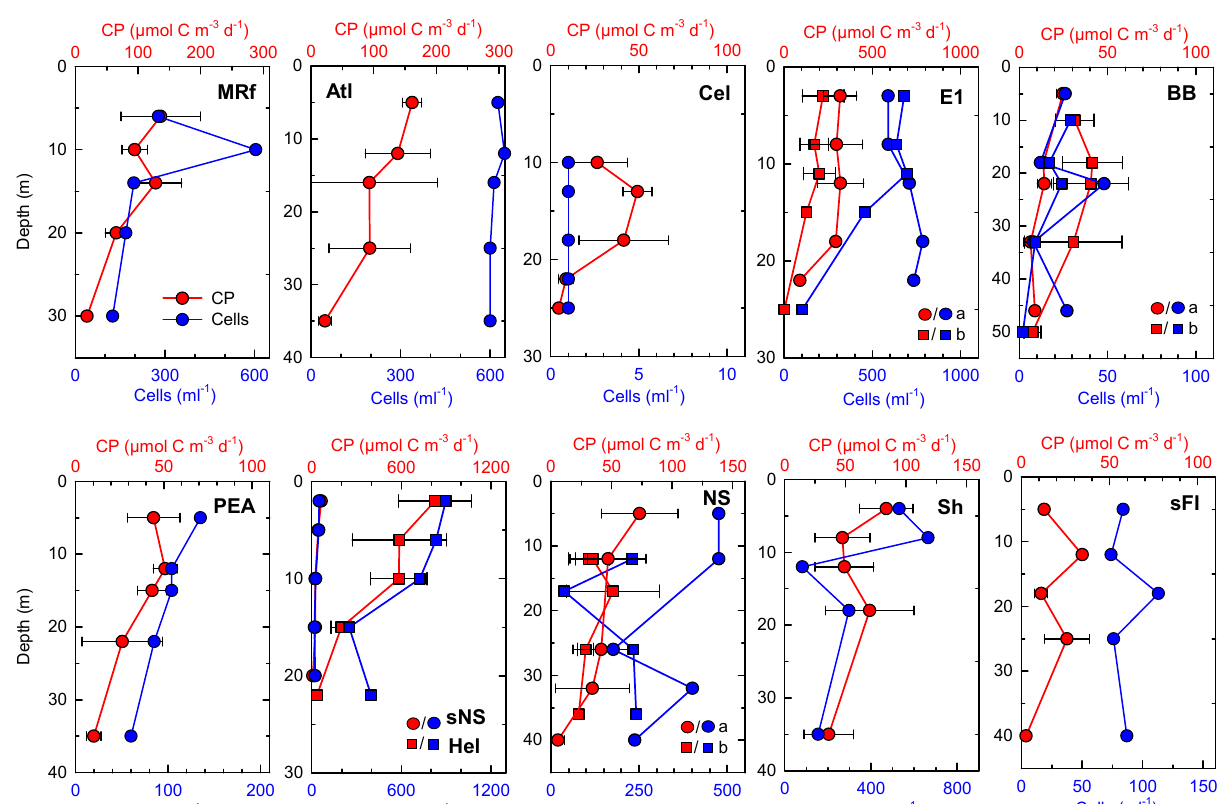
Figure 5. Vertical profiles of calcite production (CP, µmolCm − 3 d − 1 ) and coccosphere abundance (Cells, mL − 1 ) over the euphotic